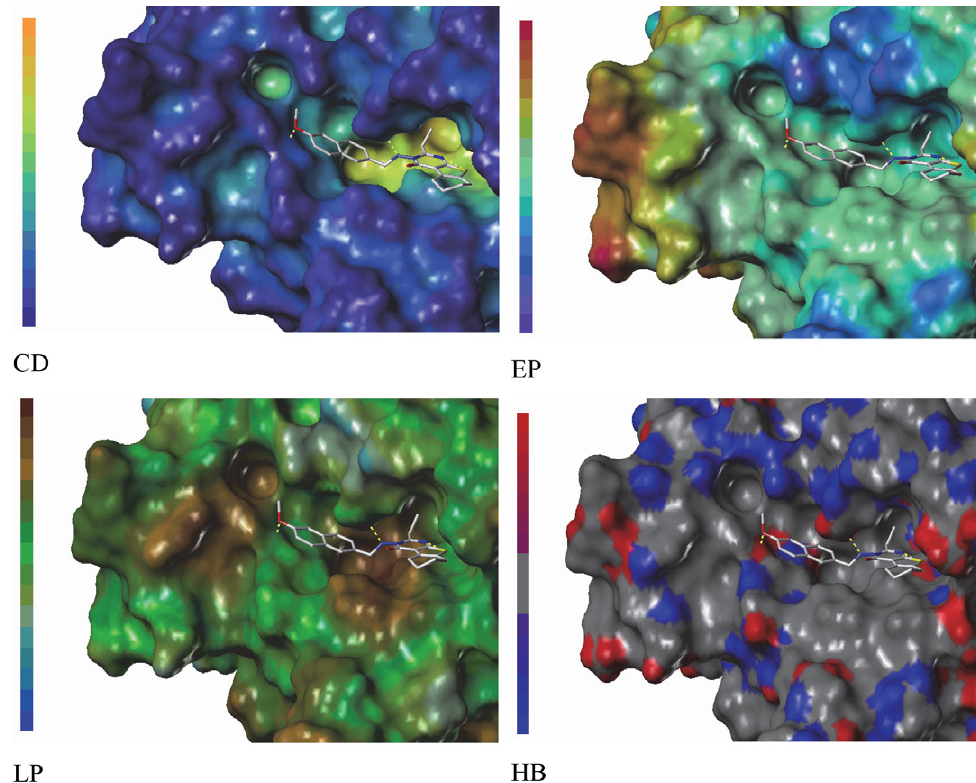
Fig. 8. MOLCAD surfaces of the binding site of DNA gyrase protein with molecule